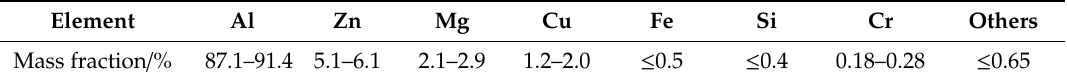
Table 1. Chemical composition of the 7075 Al